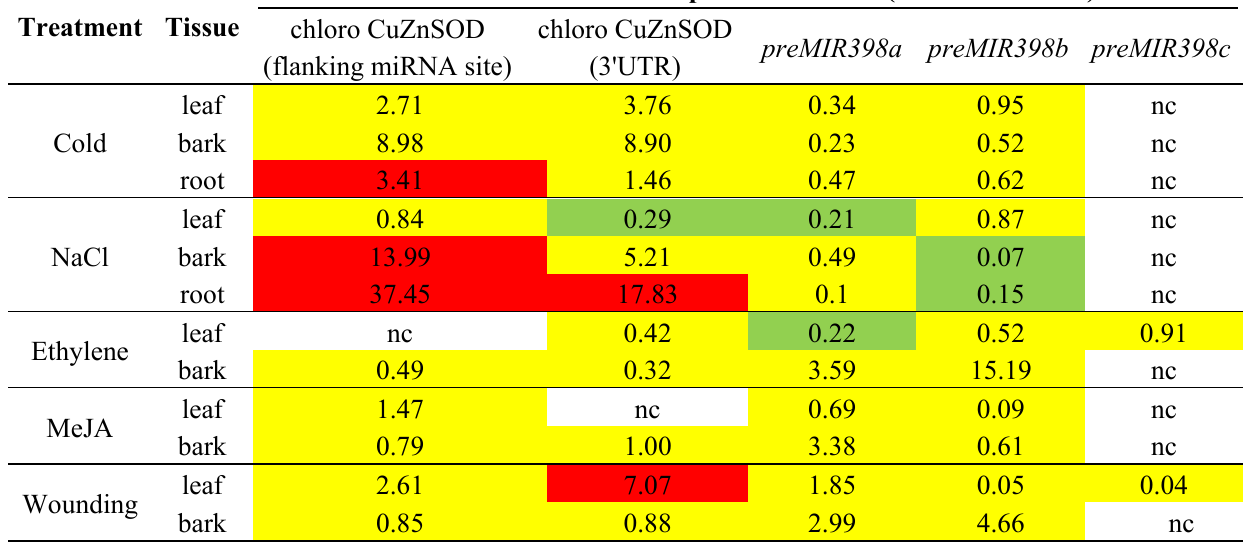
Table 4. Expression profiles of the HbMIR398a , HbMIR398b and HbMIR398c genes and their chloroplastic HbCuZnSOD target by real time-PCR in leaves, bark and roots of one-year-old Hevea brasiliensis in vitro plantlets in response to a positive cold, NaCl, ethylene, methyl jasmonate (MeJA) and wounding treatments. The statistically significant ratios ( p -value < 0.05; Tables S1 and S2) with a value over 1 ( in red ) and under 1 ( in green ), represent over-expression and under-expression, respectively, in response to the treatments. The non-significantly regulated genes are shown in yellow (nc: not calculated).